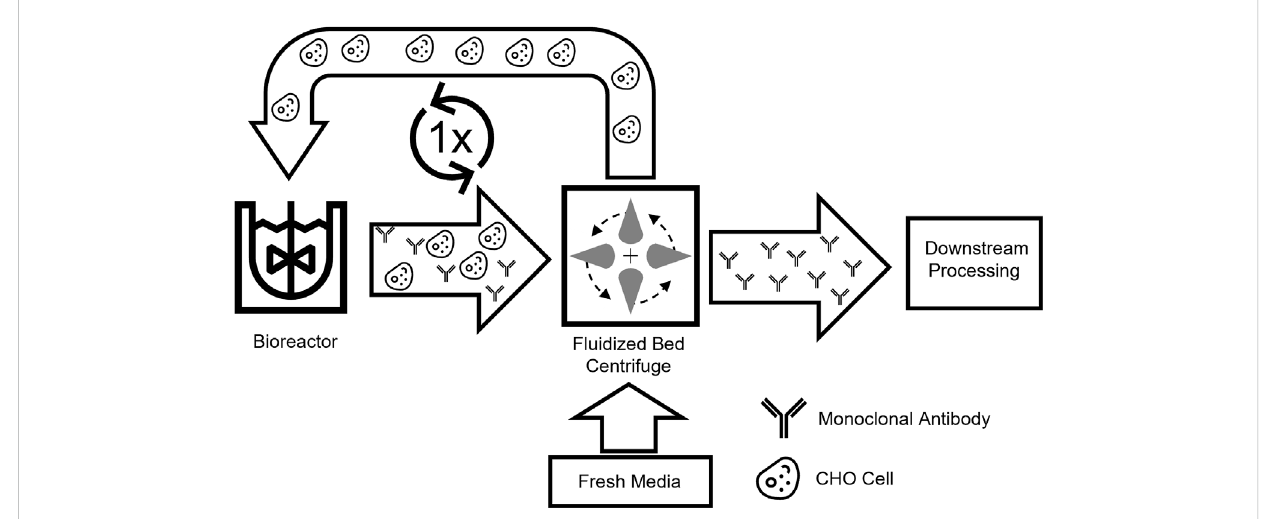
FIGURE 1 Schematicoverviewoftheintermediateharvestprocess.Cellbrothwithsecretedproductsisharvestedfromabioreactorandseparatedbyasingle- use fl uidized bed centrifuge. Afterward, the washed cells can be reintroduced into the production bioreactor and utilized in a new